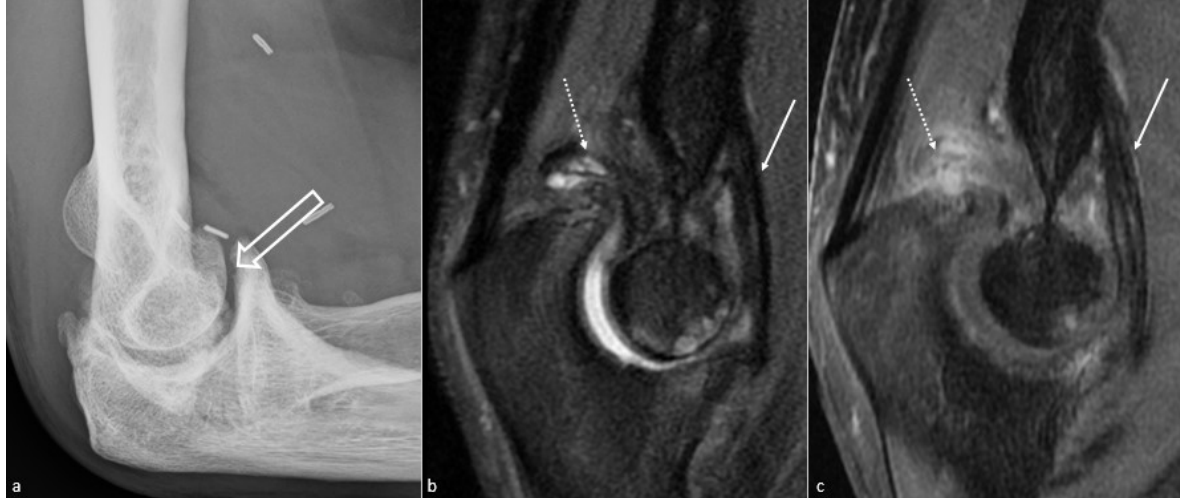
Figure 3. Anterior capsular thickening . ( a ) Profile view radiograph shows posttraumatic humeroulnar arthrosis (big white arrow), in a 45-year-old woman who suffered from a humeral fracture and presented an extension deficit. ( b ) Sagittal fat saturated T2-weighted images and ( c ) fat saturated T1-weighted gadolinium-enhanced images show anterior capsular fibrous thickening (white arrow). Additionally, note the posterior recess synovitis (dotted arrow), with a notable enhancement in ( c ), whereas no capsular thickening is seen, which also participates in the extension deficit.